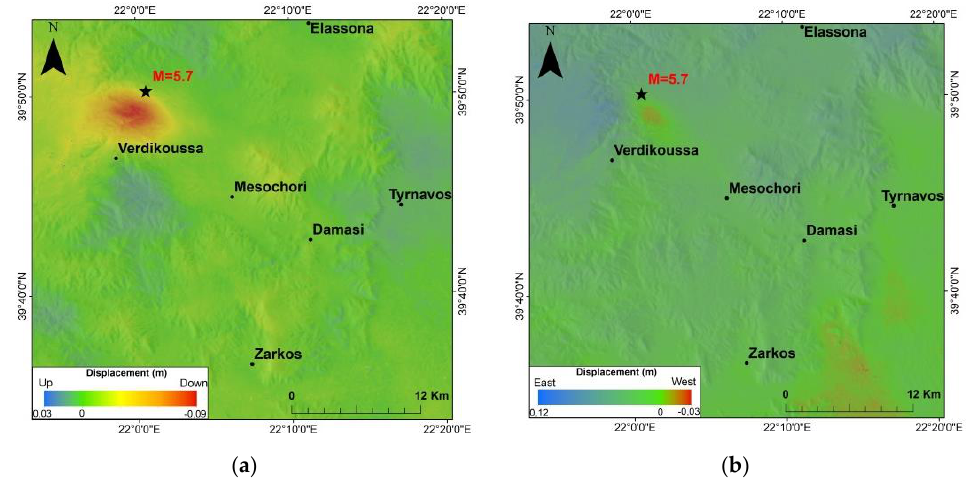
Figure 19. Earthquake of 12 March 2021: ( a ) vertical displacement, ( b ) east–west displacement; star illustrates relocated epicenter.